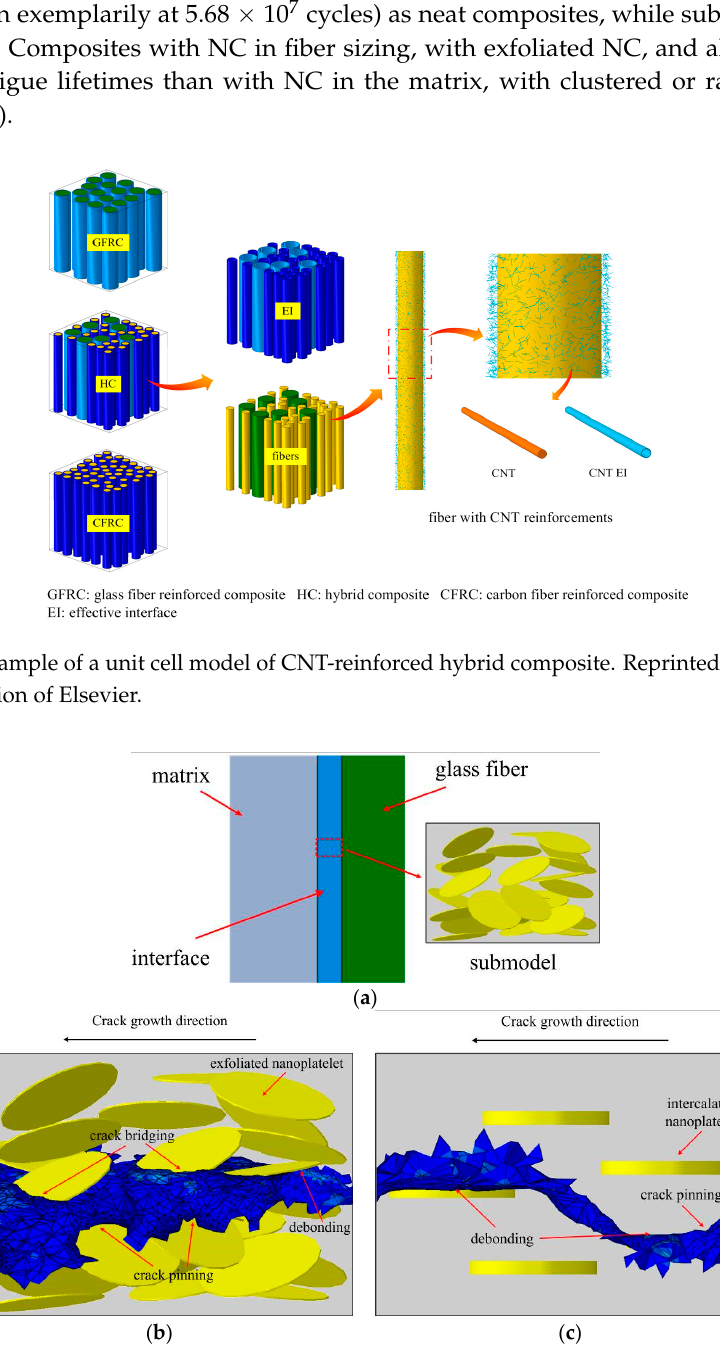
Figure 11. Schema of the model of thehierarchical fiber composite with nanoclay reinforcements ( a ) and simulated crack paths in submodels (aligned and randomly-oriented platelets ( b , c )). Reprinted from [66] with kind permission of Elsevier.